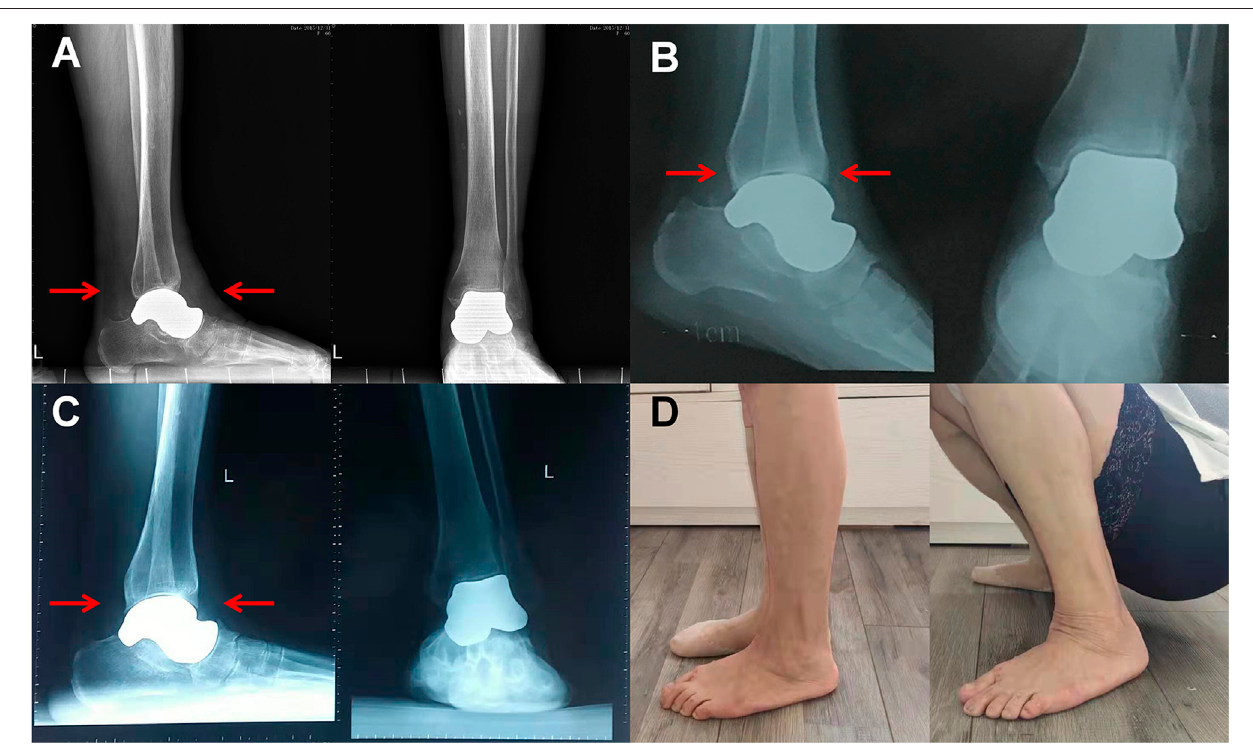
FIGURE 6 | A 58 year-old woman (patient 1) suffered from pain and swelling of the left ankle for 2 years and was unable to walk without crutches. TTR with a 3D printed Vitallium talar prosthesis was performed in 2015. Anteroposterior and lateral radiographs taken postoperatively 1, 3, and 5 years after discharge did not depict any signs of prosthesis-related complications (A – C) . The formation of small osteophytes on the tibial side and navicular side was detected (D) , but the patient did not report any discomfort and had returned to daily activities.